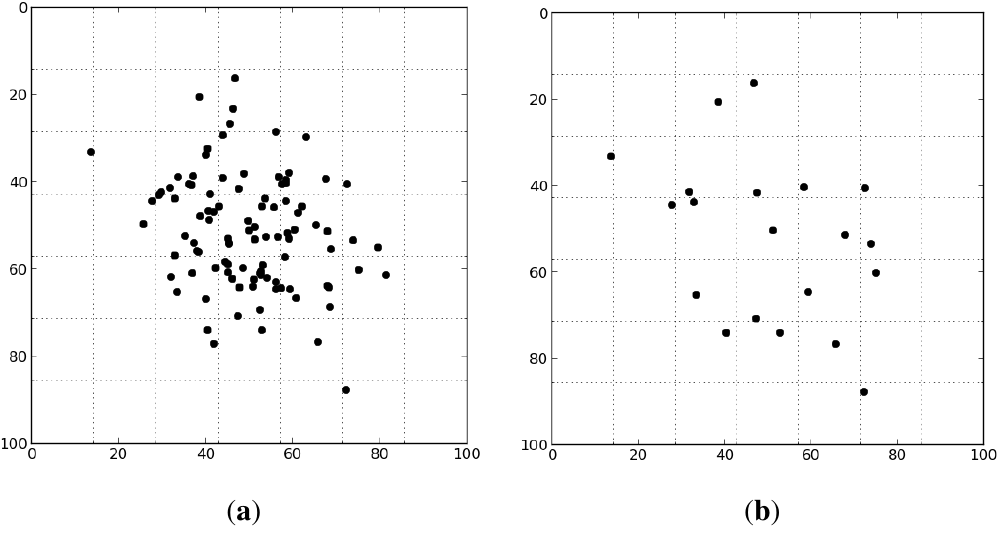
Figure 10. Selection of features with simulated data and 49 regions. ( a ) All feature matchings are associated with a region of the image; ( b ) only one feature per region is used for the optimization